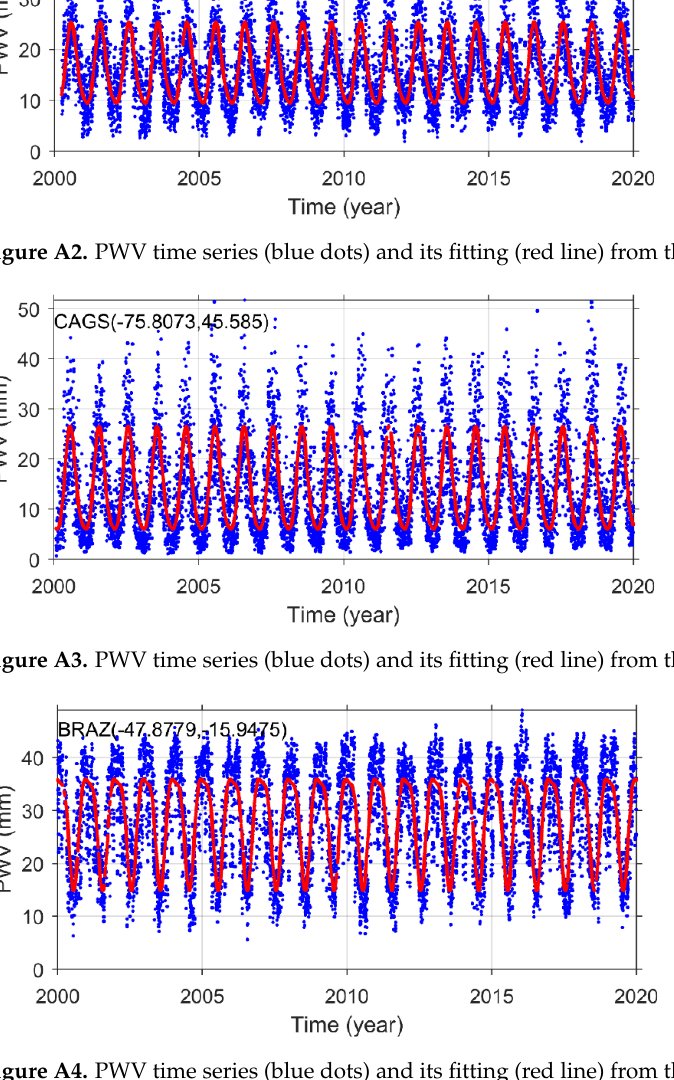
Figure A4. PWV time series (blue dots) and its fitting (red line) from the GNSS station BRAZ.